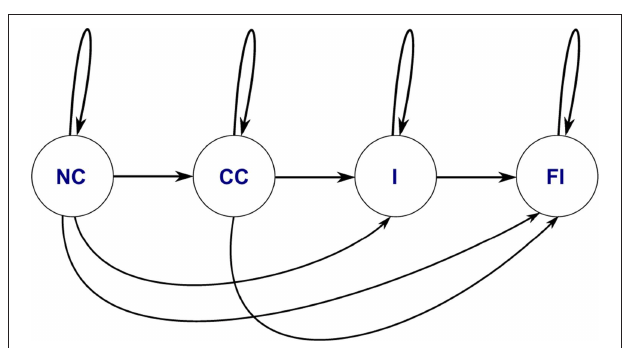
FIGURE 6 | HMM topology of the PiH insertion process based on the given dataset in Equation